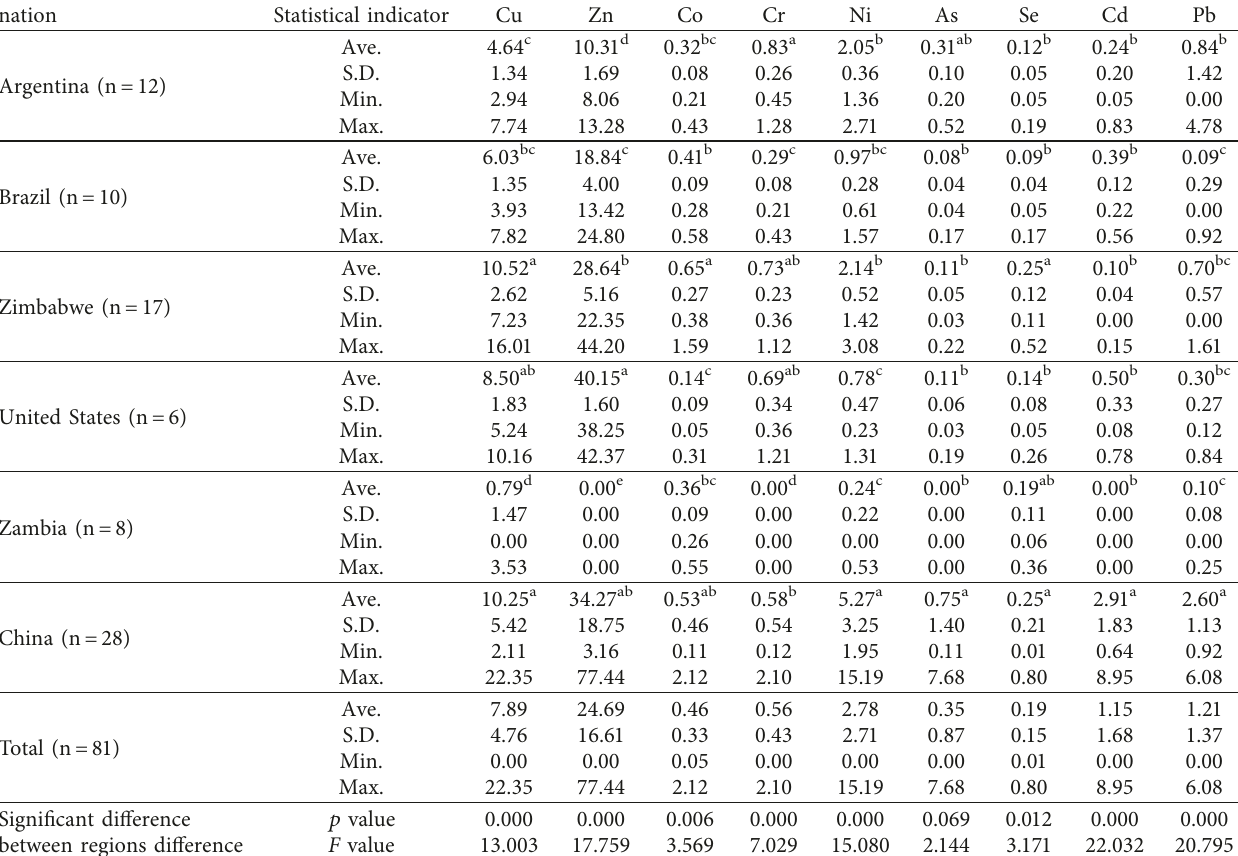
Table 1: Mineral element content in the tobacco leaf from different countries (mg/kg). nation Statistical indicator